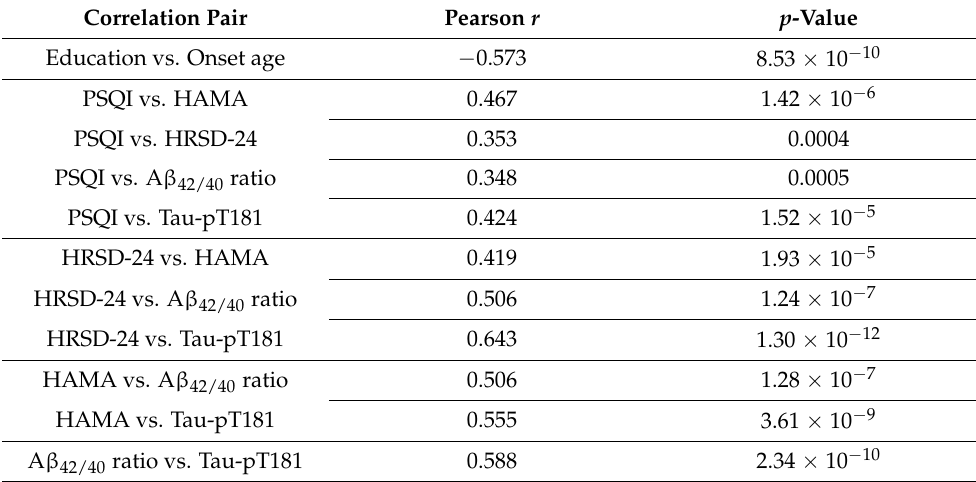
Table 2. Pearson Correlation Coefficient.